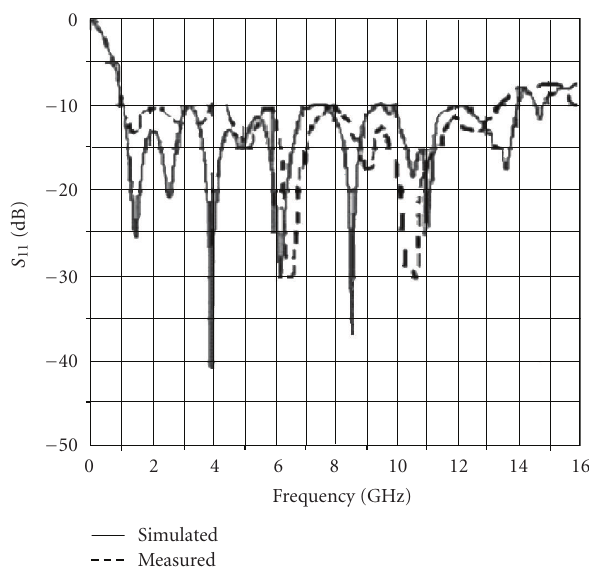
Figure 8: Return loss plots of a PEMA with 2 A = 4 . 8cm and 2 B = 5 . 2 cm (—–) simulated, (– – –)